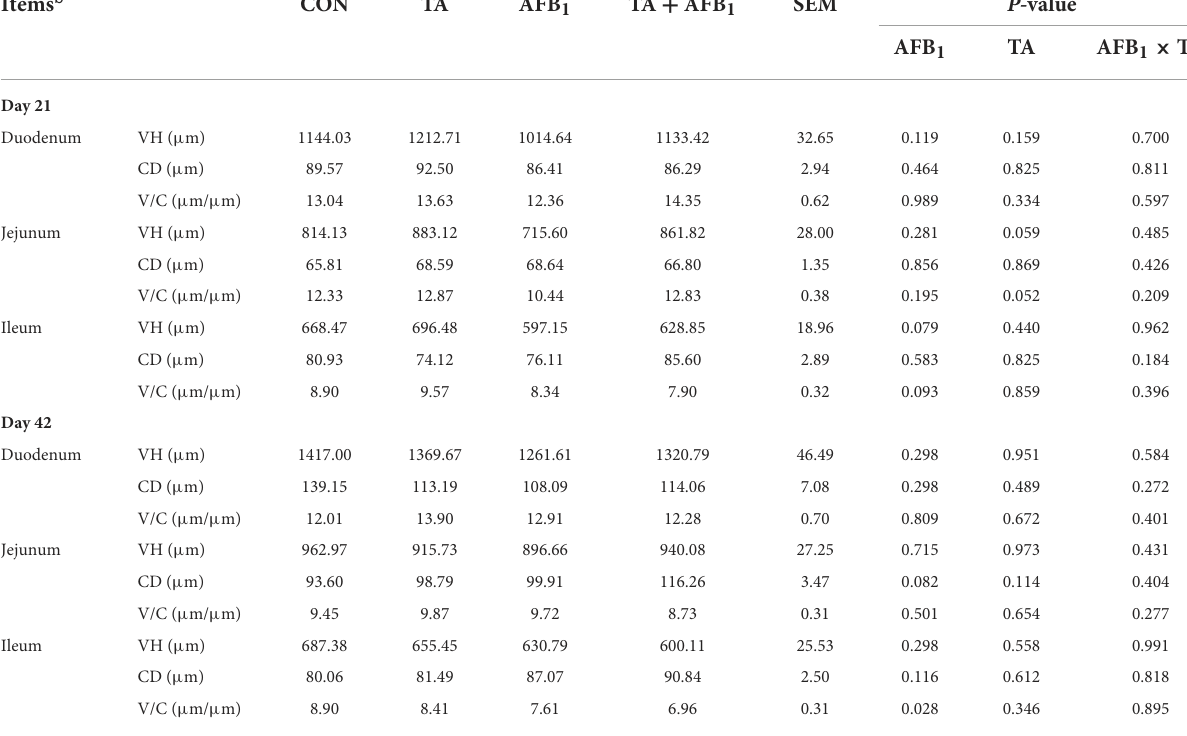
TABLE 4 Effects of tannic acid on intestinal histomorphology of broilers challenged with AFB a 1 .